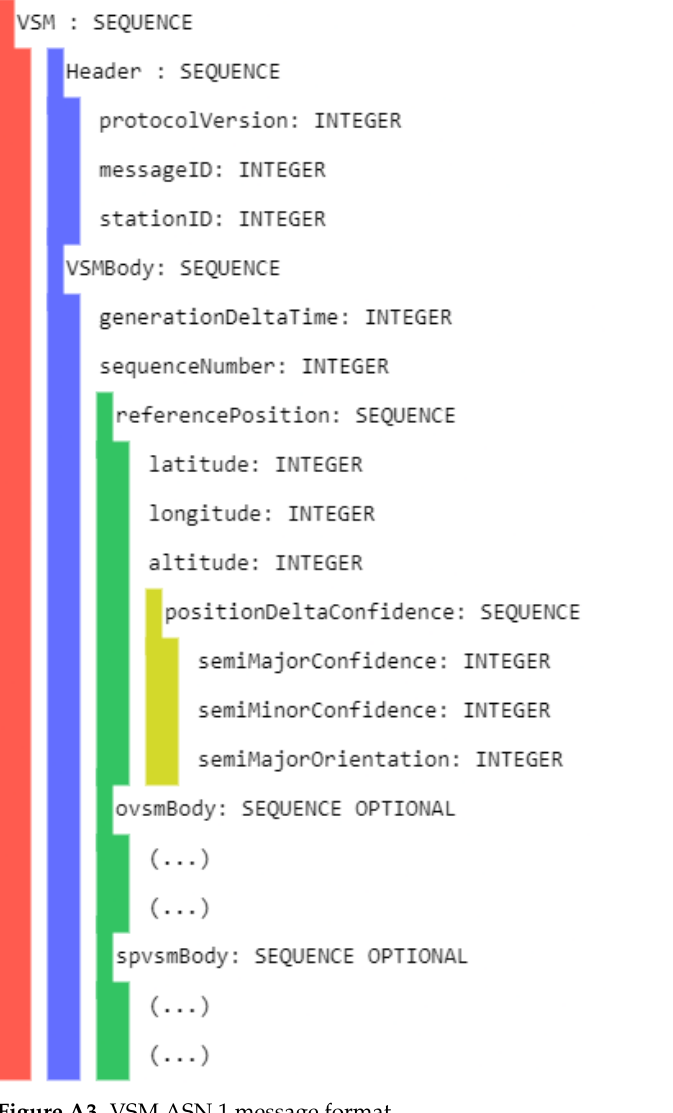
Figure A3. VSM ASN.1 message